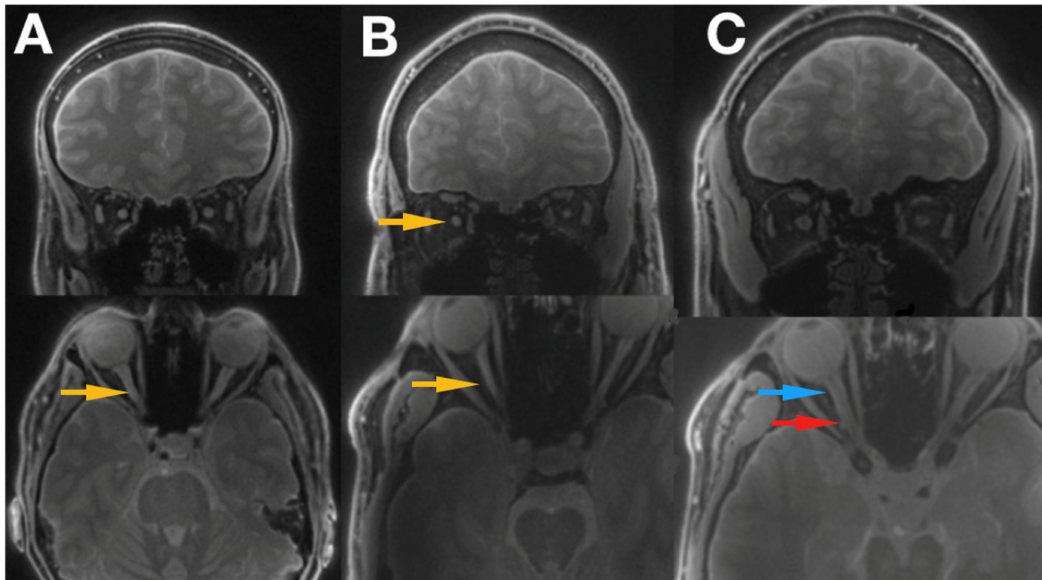
optic nerve. LHON, Leber’s hereditary optic